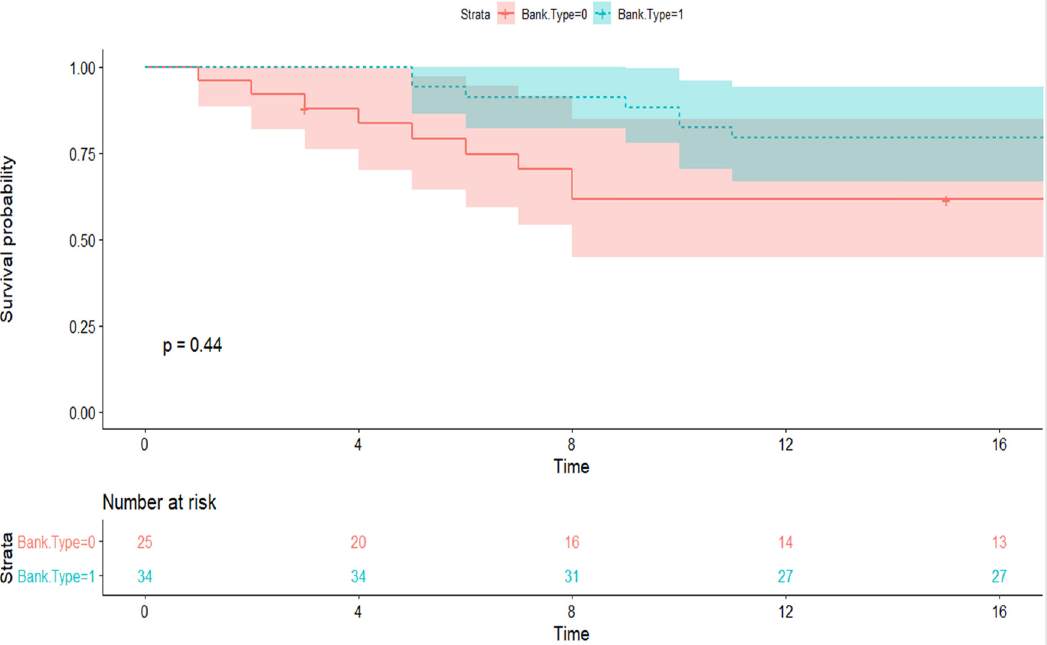
Figure 3: Unconditional survivor function estimates for Bank_Type ( public and private sector banks ) ( Bank_type = 0 indicates private bank and Bank_type = 1 public sector banks. ) .